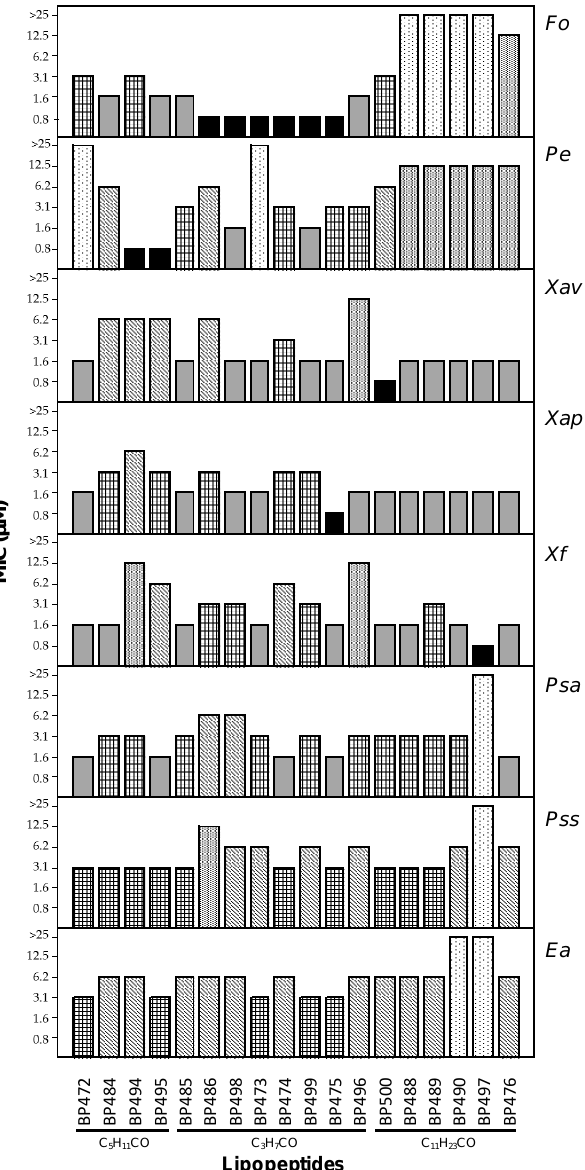
Figure 1. Antimicrobial activity of lipopeptides against the bacteria E. amylovora ( Ea ), P. syringae pv. syringae ( Pss ), P. syringae pv. actinidiae ( Psa ), X. fragariae ( Xf ), X. arboricola pv. pruni ( Xap ) and X. axonopodis pv. vesicatoria ( Xav ), and the fungi P. expansum ( Pe ) and F. oxysporum ( Fo ). The type of acyl group is indicated below the lipopeptides. Antimicrobial activity is given as the minimal concentration that inhibits growth (MIC). The MIC axis is in logarithmic scale, and for each sequence, the lowest values of the MIC range is represented. Data can be found in Table S1 (Supplementary Materials).